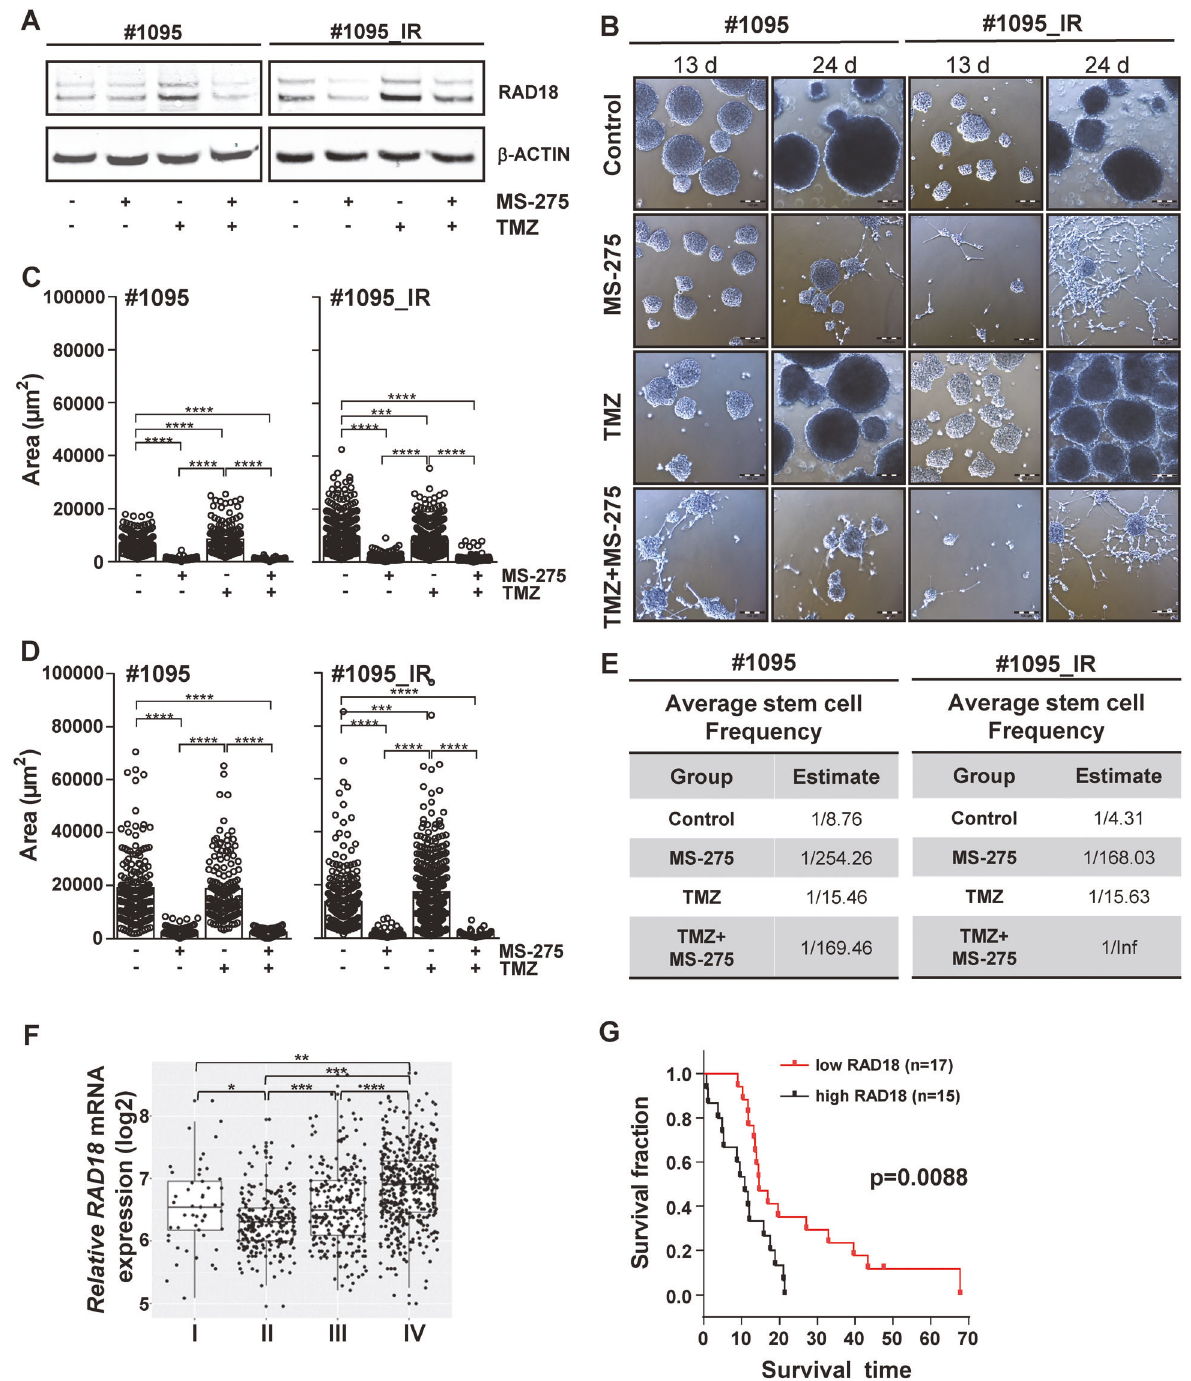
Fig. 6 Effect of MS-275 on glioma initiating cells and the role of RAD18 in glioma patients. A Downregulation of RAD18 protein expression upon MS-275 exposure. Glioma initiating cells #1095 and #1095_IR were exposed to indicated drugs for 72 h. ß-ACTIN served as a loading control. B HDACi prevents the proliferation of glioma initiating cells. Micrographs of #1095 and #1095_IR cells after 13 and 24 days of indicated drug exposure (magni fi cation, x40, scale bar, 100 µm). C Quanti fi cation of #1095 and #1095_IR spheroid size 13 days after treatment. D Quanti fi cation of #1095 and #1095_IR spheroid size 24 days after treatment. E MS-275 impairs the self-renewal potential of glioma initiating cells. Comparison of self-renewal potential in #1095 and #1095_IR upon indicated drug exposure by ELDA. The average stem cell frequency of both cell lines under indicated treatments result from three independent experiments and are shown. F RAD18 mRNA expression in glioma grade I, II, III, IV. Log2 fold-changes in expression are represented as box and dot-plots of each subtype and the indicated signi fi cances * P ≤ 0.05; ** P ≤ 0.01 and *** P ≤ 0.001 result from t -test. G RAD18 mRNA expression correlates with survival of glioblastoma patients. Kaplan – Meier plot comparing the survival of GBM patients suffering from high RAD18-expressing glioblastomas ( n = 15) and low RAD18 -expressing glioblastomas ( n = 17). Indicated signi fi cance result from log-rank test. For A , B , C , and D cells were exposed to MS-275 (1.5 µM), TMZ (50 µM) and TMZ/MS-275. Inf = in fi nity. P ≤ 0.001 and **** P ≤ 0.0001. Indicated signi fi cances result from an unpaired t -test. Cell Death and Disease (2022)